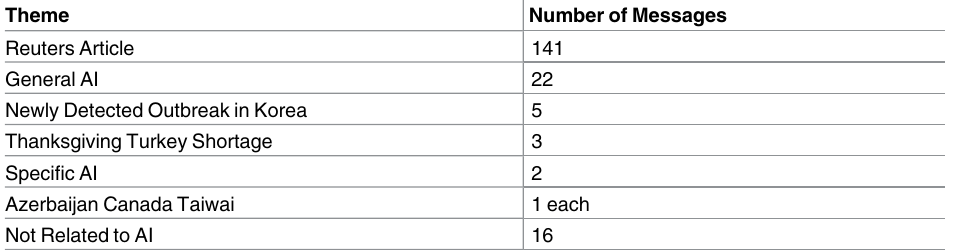
Table 7. Top ranking locations based on profile of account for static and dynamic outbreak AI-related Tweets on October 26 th , 2016. Theme Number of